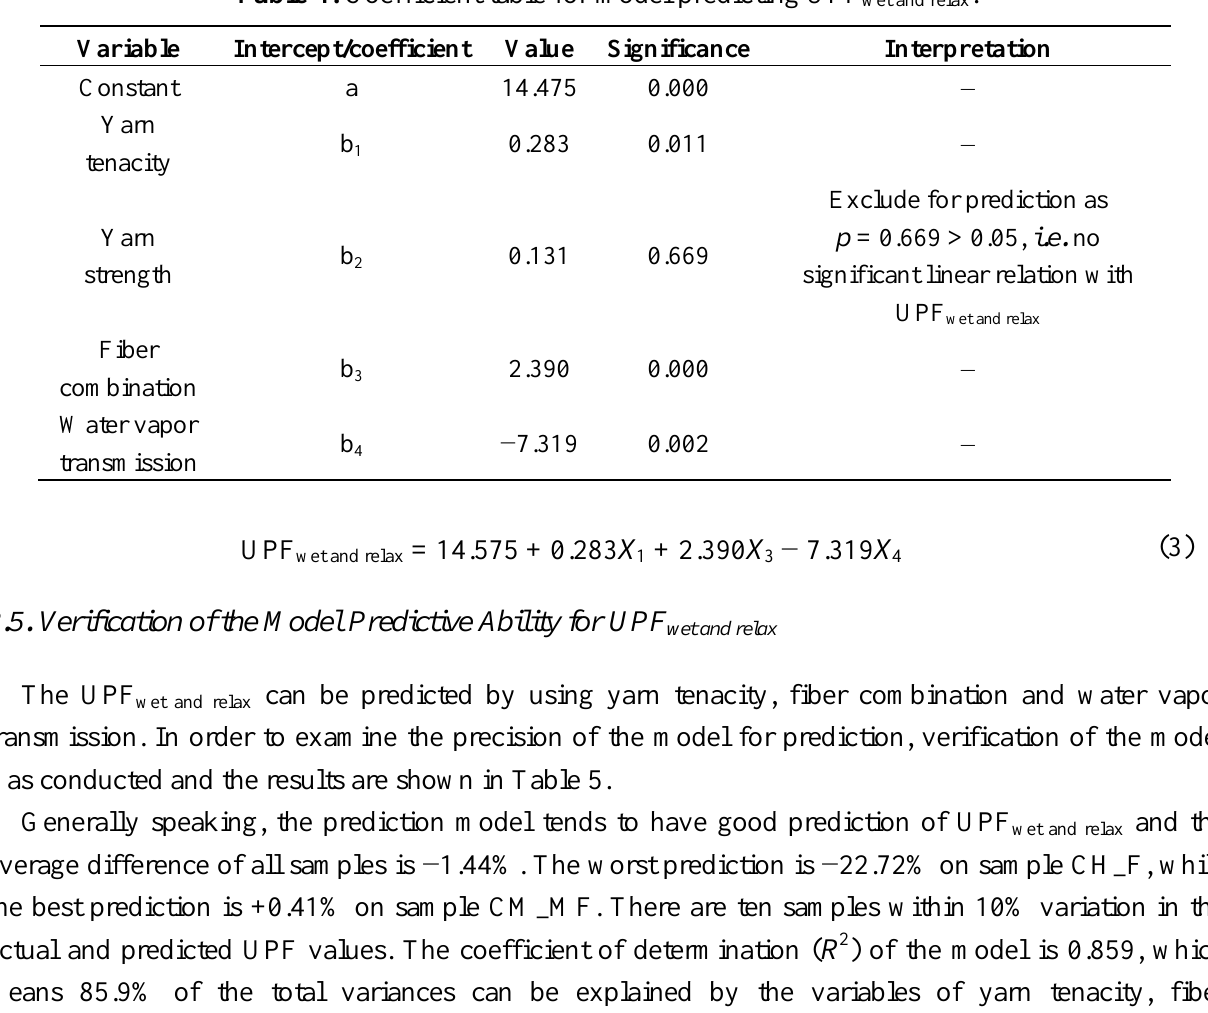
Table 4. Coefficient table for model predicting UPF